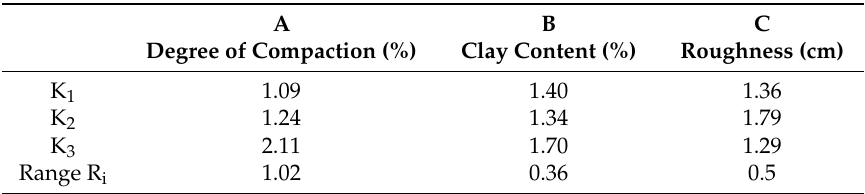
Table 6. Range analysis results of interface internal